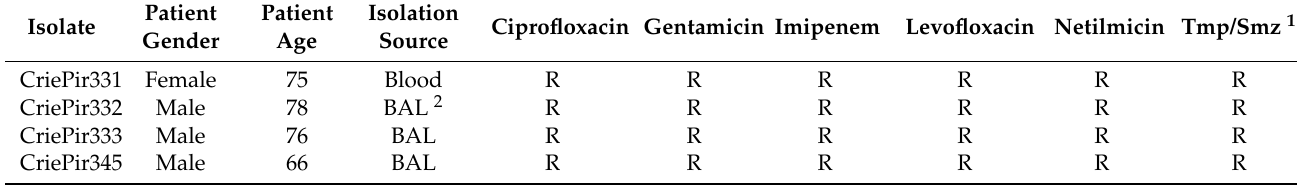
Table 1. Antibiotic resistance phenotype and metadata for A. baumannii